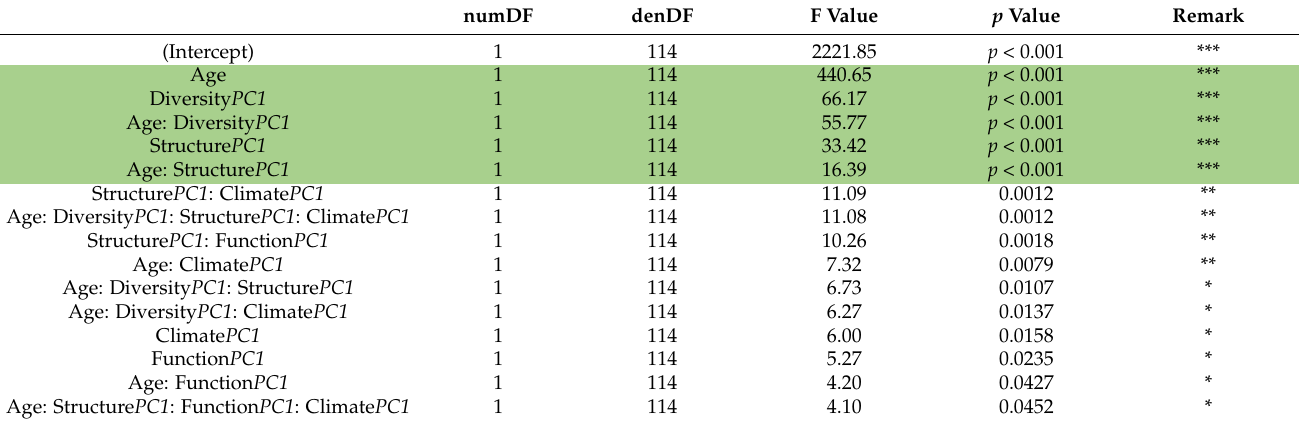
Table 4. Summary of the linear mixed-effect model of the effects of age, diversity PC1 , structure PC1 , function PC1, and climate PC1 on aboveground wood carbon, which were analyzed for the broadleaf mixed forests (BMF). PC1 refers to the first principal component of the results of principal component analysis. The colons represent interactions between the components. Only significant components ( p < 0.05) are reported, and the green areas are the highly significant influence components. numDF denDF F Value p